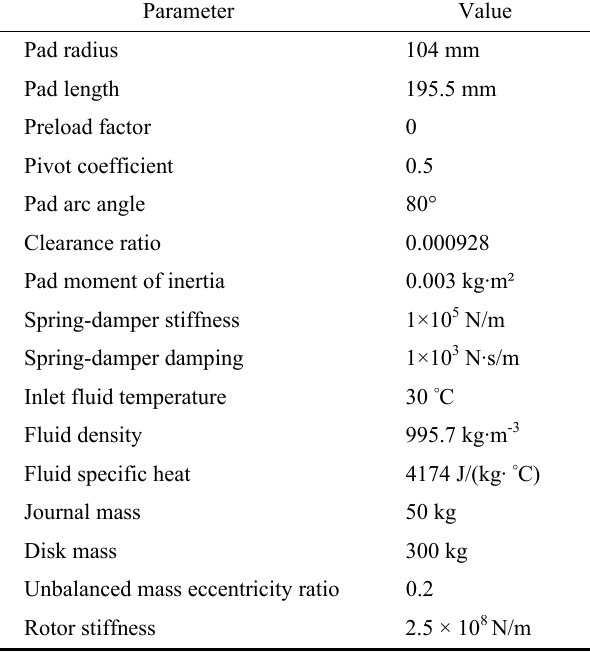
Table 1 Structural and operational parameters of the TPJB-rotor